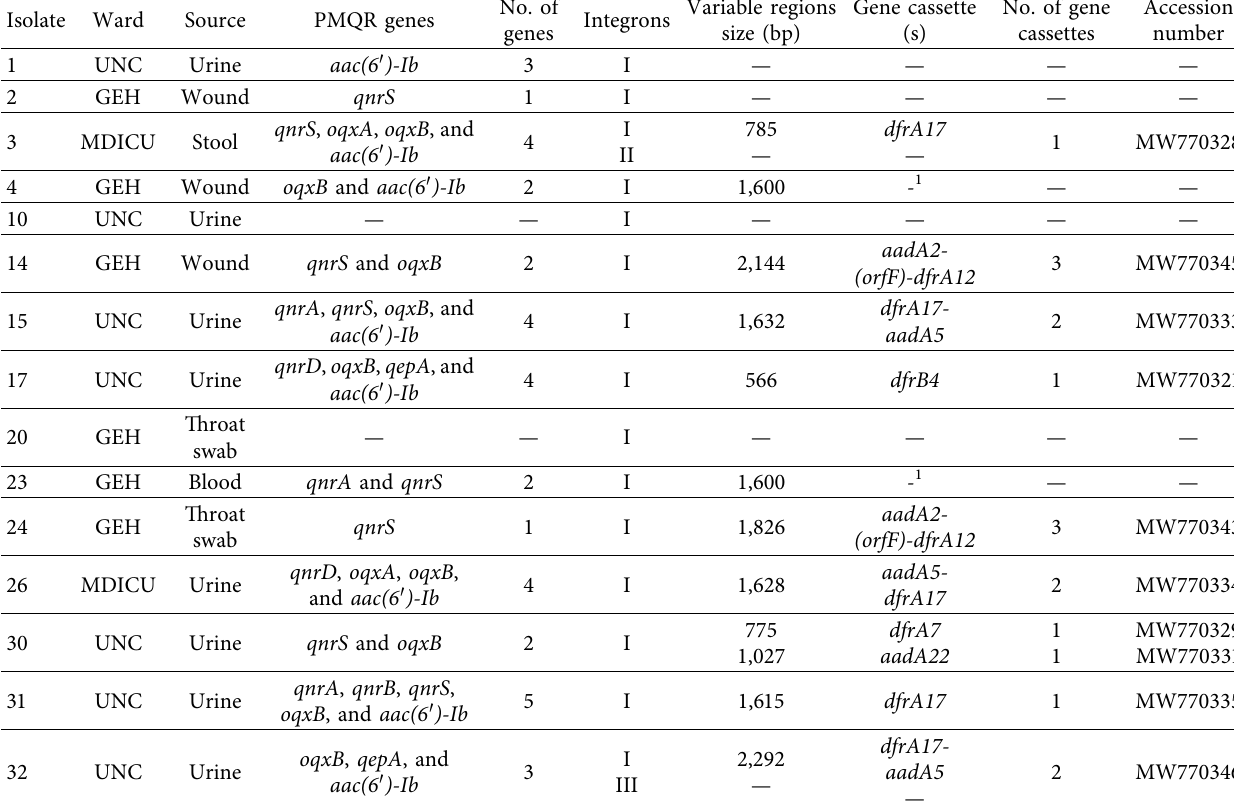
Table 5: Characterization of 43 quinolone-resistant integron-positive clinical E. coli isolates.